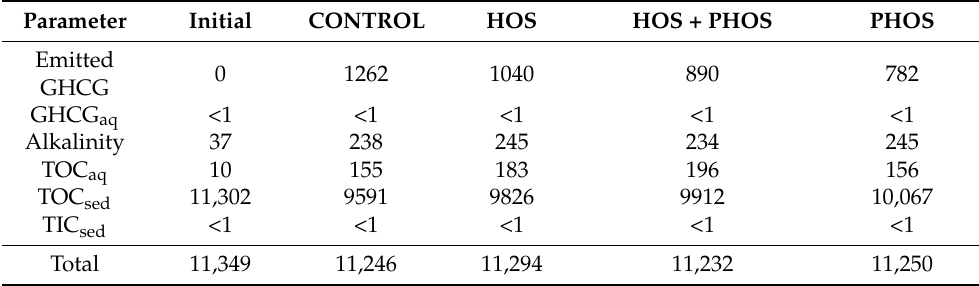
Table 4. Carbon mass balances for the experimental reactors (mmol m − 2 ).